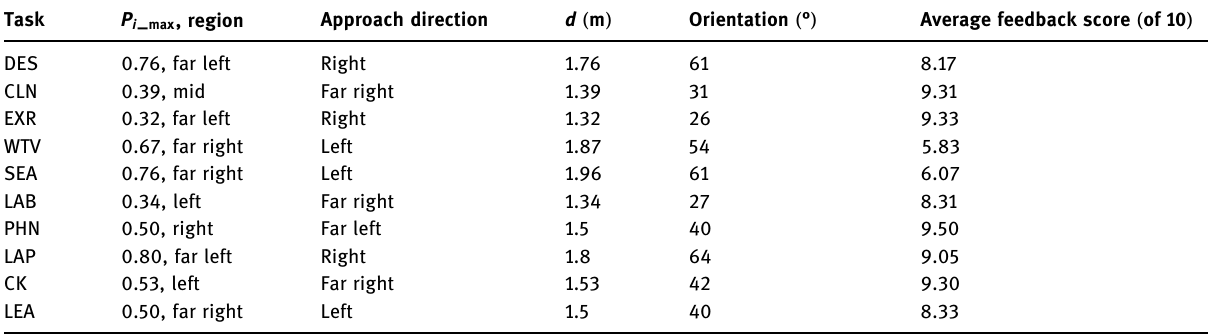
Table 2: Results of ten scenarios during the experiment and average feedback score received for each task